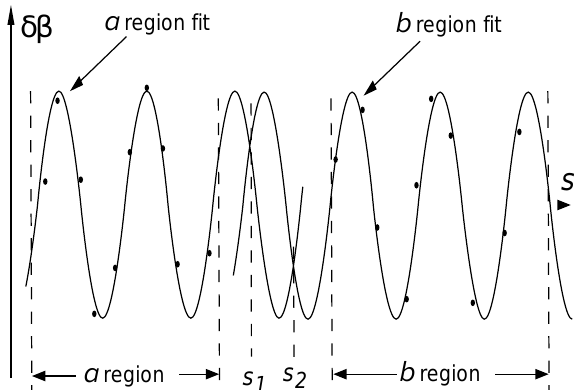
FIG. 1. Schematic diagram of the analysis to find a quadrupole error using a b measurement. Fits to db in regions a and b give sinusoidal-like “free waves.” Pictorially, the possible error locations (labeled s 1 and s 2 in this example) can be found by extending the two fits into the region between a and b . The error locations are where the fits